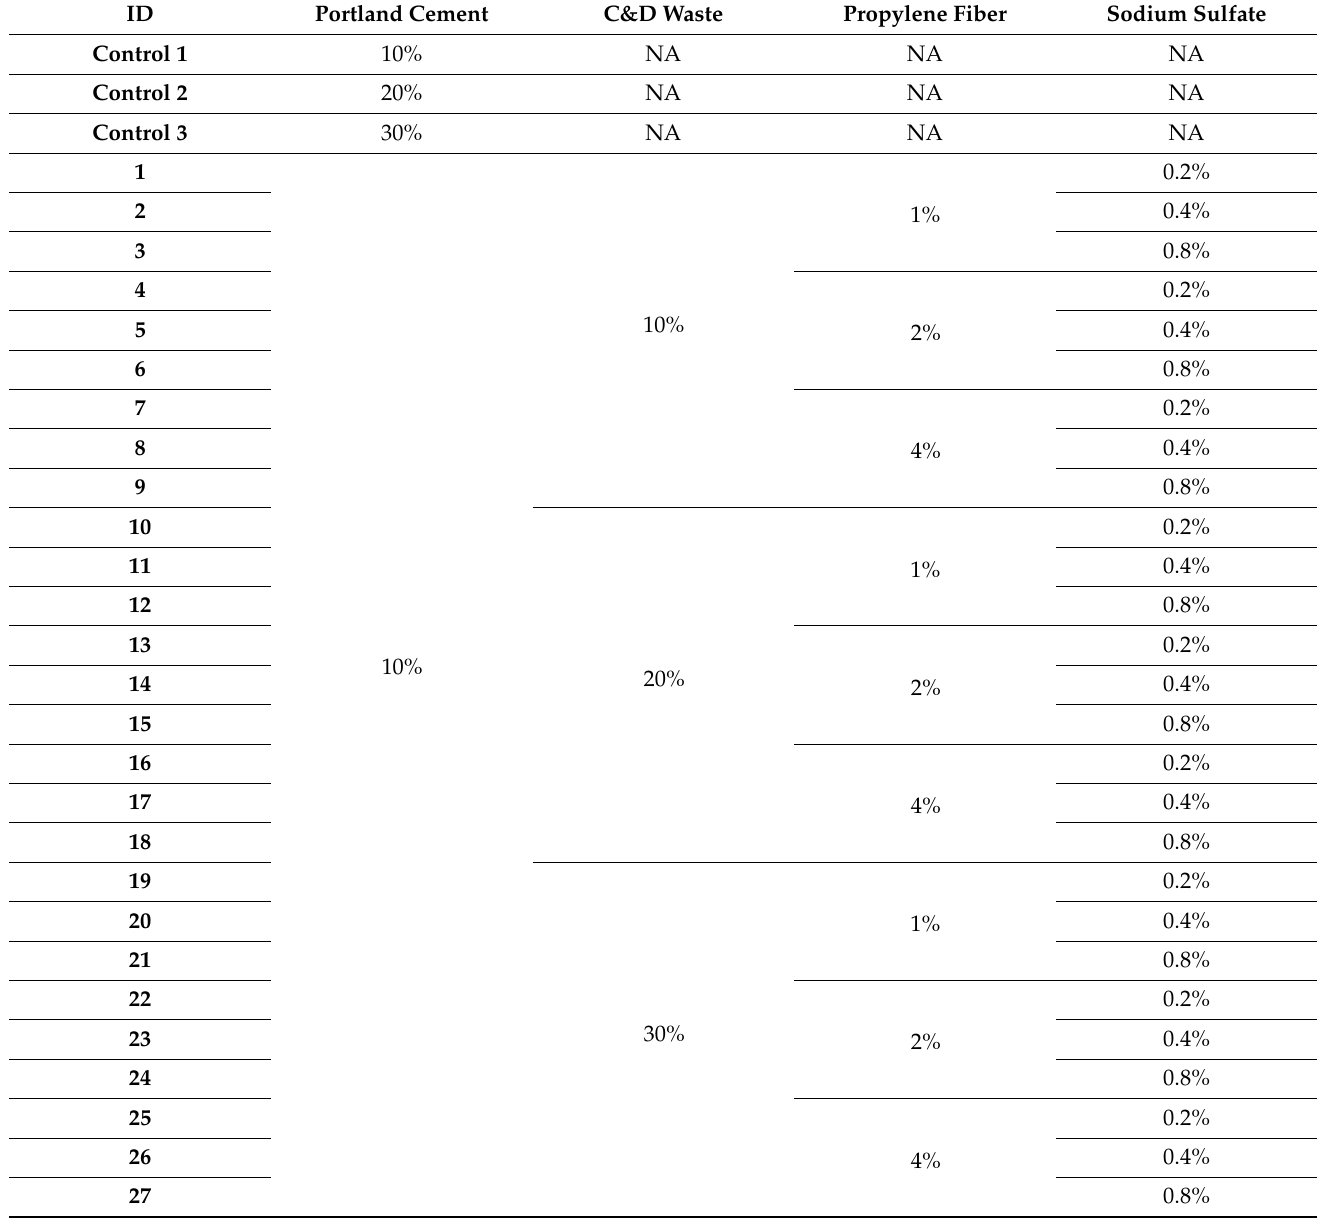
Table A1. The Portland Cement, C&D waste, propylene fiber, and sodium sulfate proportion of the samples in this